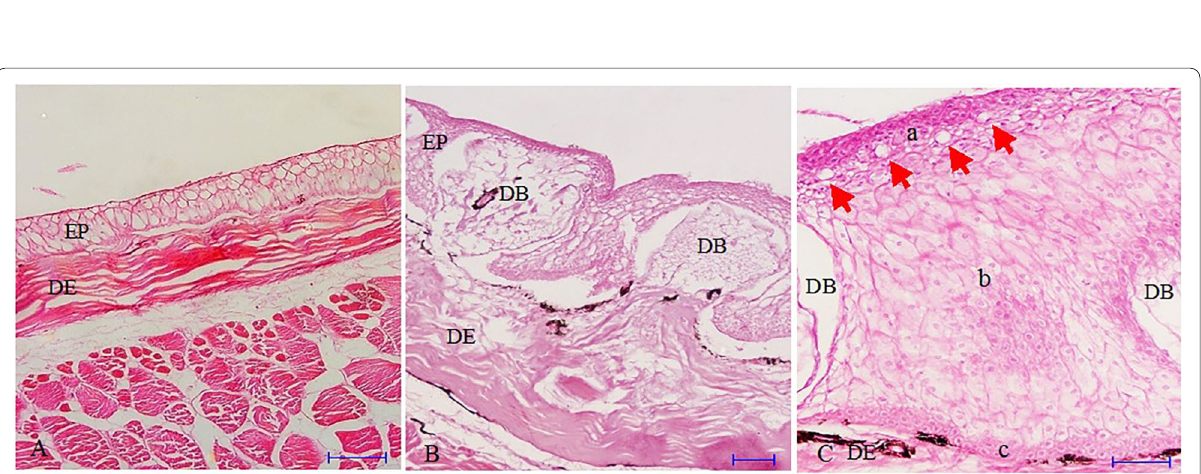
Fig. 2 Microscopic structure of skin in B. dussumeri (5 μm section, Hematoxylin-Eosin staining). A Ventral skin (Scale bar 50 μm), B Dorsal skin (Scale bar 20 μm), C Dorsal skin (Scale bar 20 μm). (EP): Epidermis, (DE): Dermis, (DB): Dermal bulge, a Stratum germinativum, b Middle layer, c Superficial layer, Red arrow: Mucous